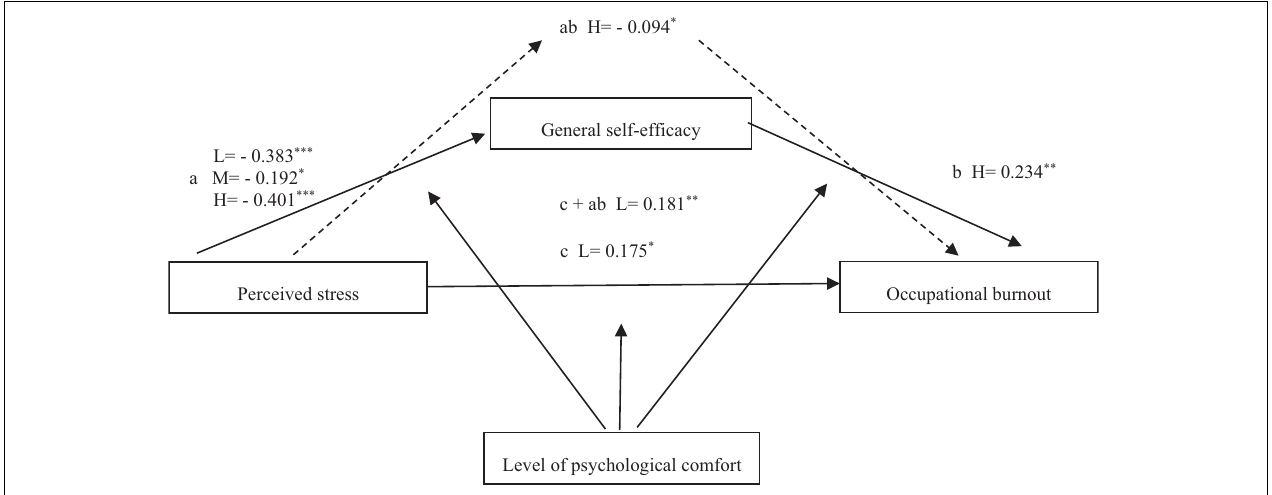
FIGURE 1 | Model 1. Relationships between perceived stress, general self-efficacy and occupational burnout moderated by level of psychological comfort in a group of Polish ECD’s. L = low level of psychological comfort. M = medium level of psychological comfort. H = high level of psychological comfort. ∗ β is significant at the 0.05 level. ∗∗ β is significant at the 0.01 level. ∗∗∗ β is significant at the 0.001 level. For the readability of the graph, the graphic markings of irrelevant paths were omitted.